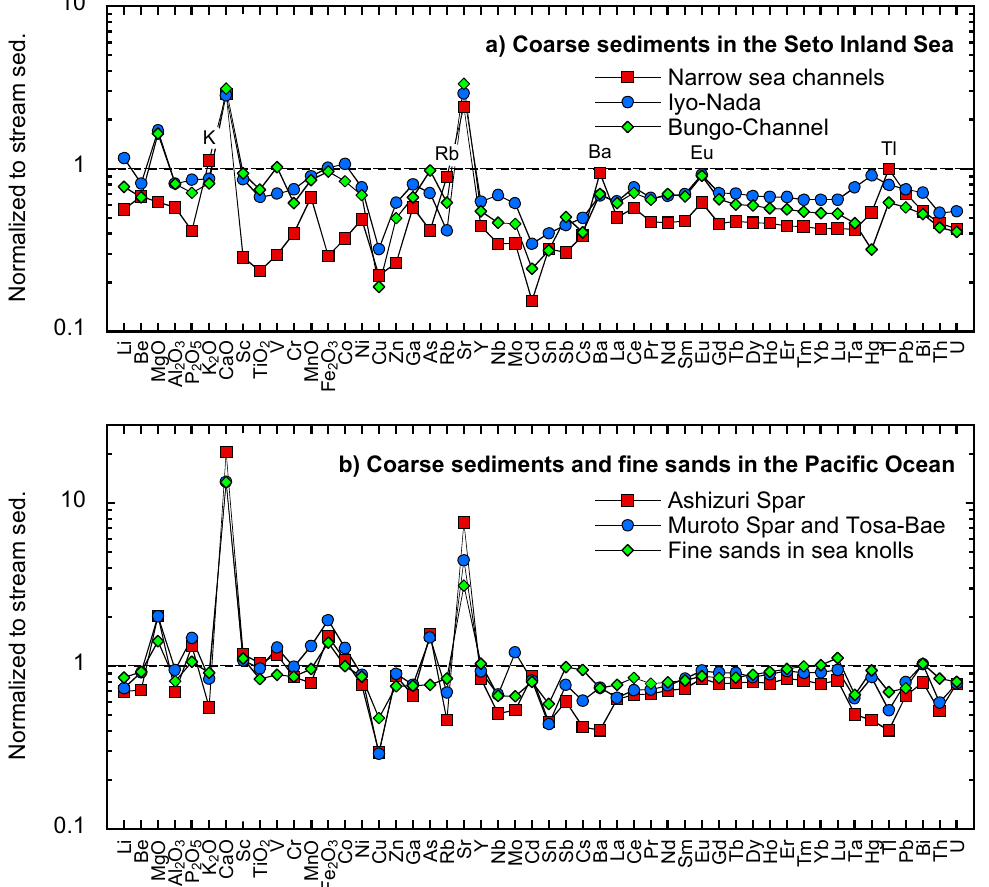
Figure 8. ( a ) Profiles of chemical compositions of coarse sediments in the narrow sea channels (around Aki-Nada, Bisan-Seto-Nada, and Awaji Island), Iyo-Nada, and the Bungo Channel, normalized to stream sediments in the Seto Inland Sea region; ( b ) Profiles of chemical compositions of coarse sediments in Ashizuri Spar, Muroto Spar and Tosa Bae, and fine sands in sea knolls normalized to stream sediments in the Pacific Ocean region.